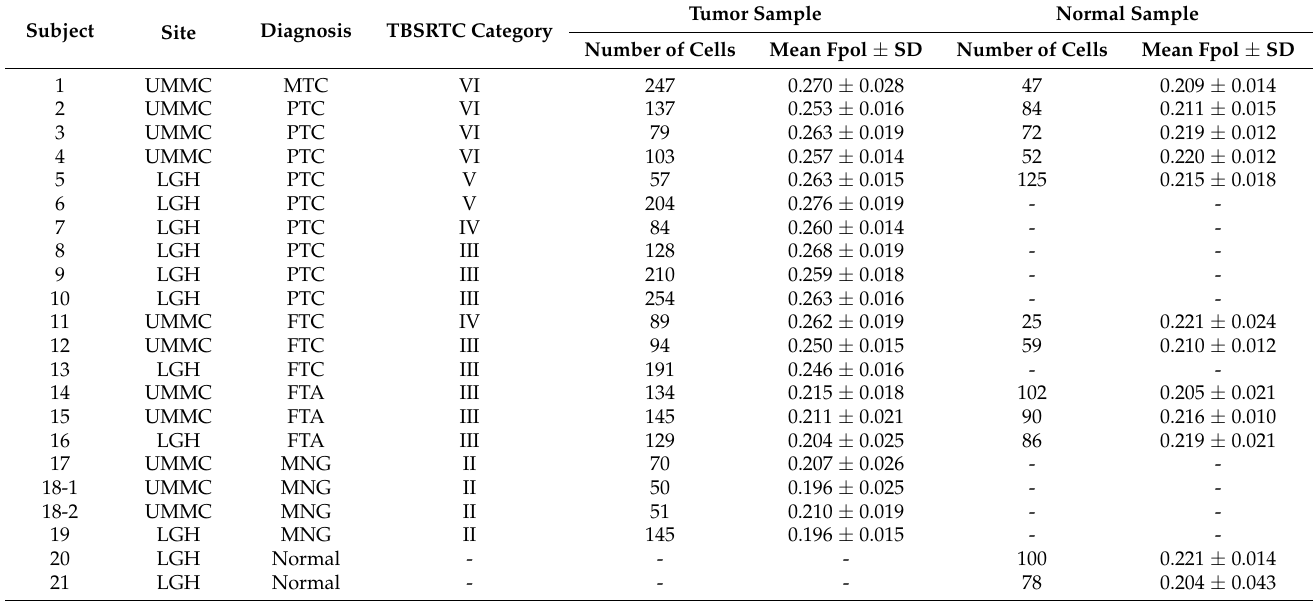
Table 1. Clinical information and experimental data for 32 thyroid samples obtained from 21